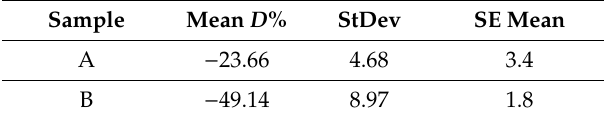
Table 3. TGA weight loss for A and B samples: mean, standard deviation, and mean square error.